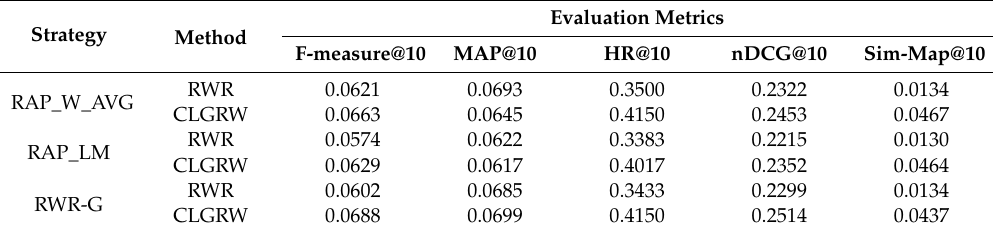
Table 2. Performance of RWR and C ontext-aware L ocation Recommendation for G roups with R andom W alk (CLGRW) approaches and two group recommendation strategies, including an aggregated prediction strategy with weighted aggregation and least misery policies, respectively abbreviated by RAP_W_AVG and RAP_LM, and extension of the RWR to group (RWR-G) on U-V (user-location) graph (group size: two members).